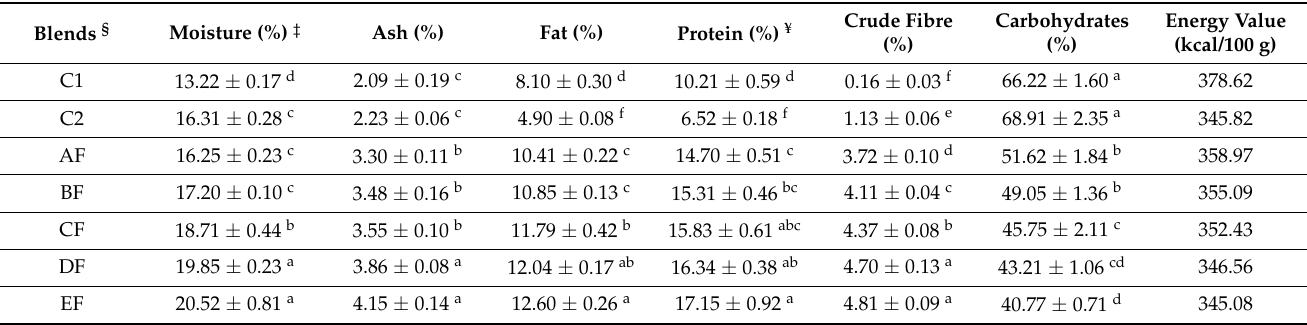
Table 2. Proximate composition and energy value of gluten-free